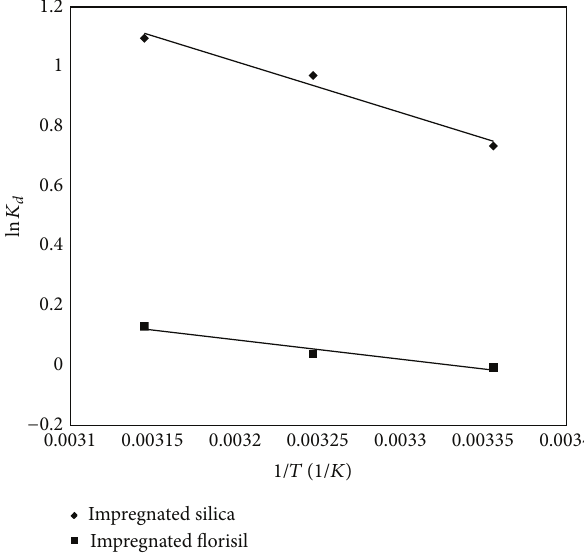
Figure 9: Temperature effect on the adsorption of As(V) onto impregnated silica and